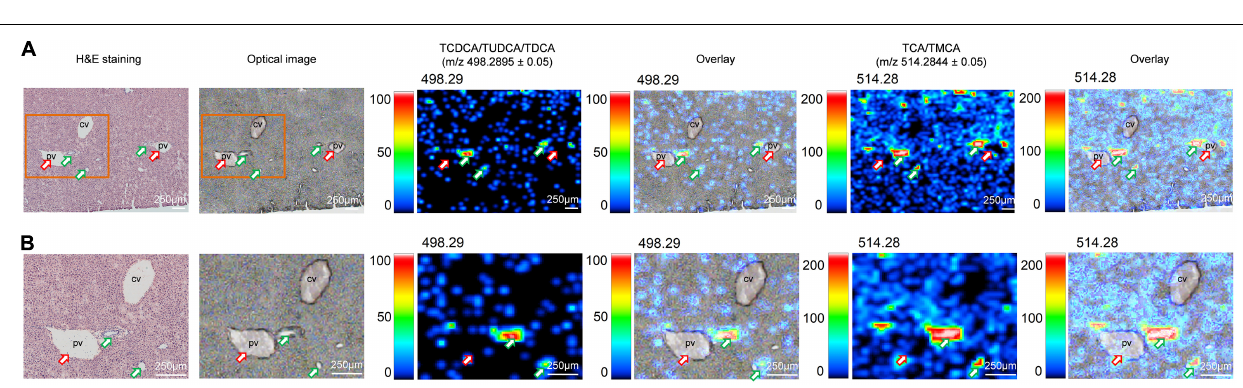
FIGURE 2 | Imaging MS visualize the zonation patterns of BA metabolism in liver of HFD-fed mice. MS ion images representing spatial distributions of the identified taurine-conjugated BAs at m/z 498.2895 ± 0.05 (TCDCA/TUDCA/TDCA) and m/z 514.2844 ± 0.05 (TCA/TMCA) for the mouse liver in same tissue section at high spatial resolution. Overlay: Overlay of each MS ion image and optical image. All ion images were normalized to the 9AA matrix signal. The green arrows indicated bile ducts, whereas the red arrows showed blood vessels. Scale bars: 250 µ